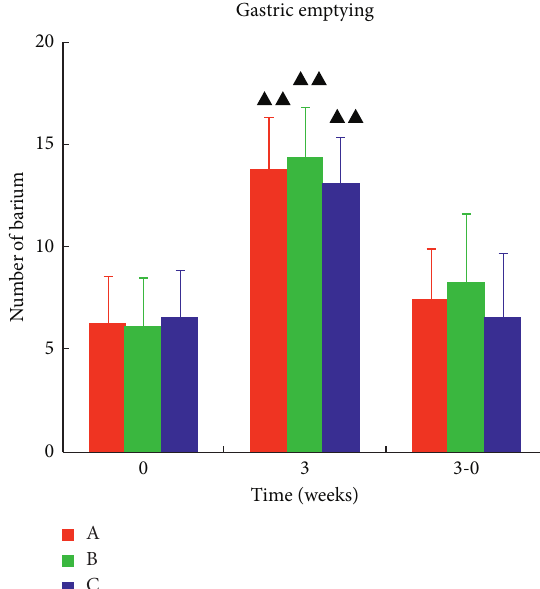
Figure 5: Comparison of gastric emptying before and after treatment in each group of patients. The value is “20—the number of remaining bars,” and the data were expressed as mean ± s ( n � 33). ΔΔ P < 0 . 01, compared with the baseline